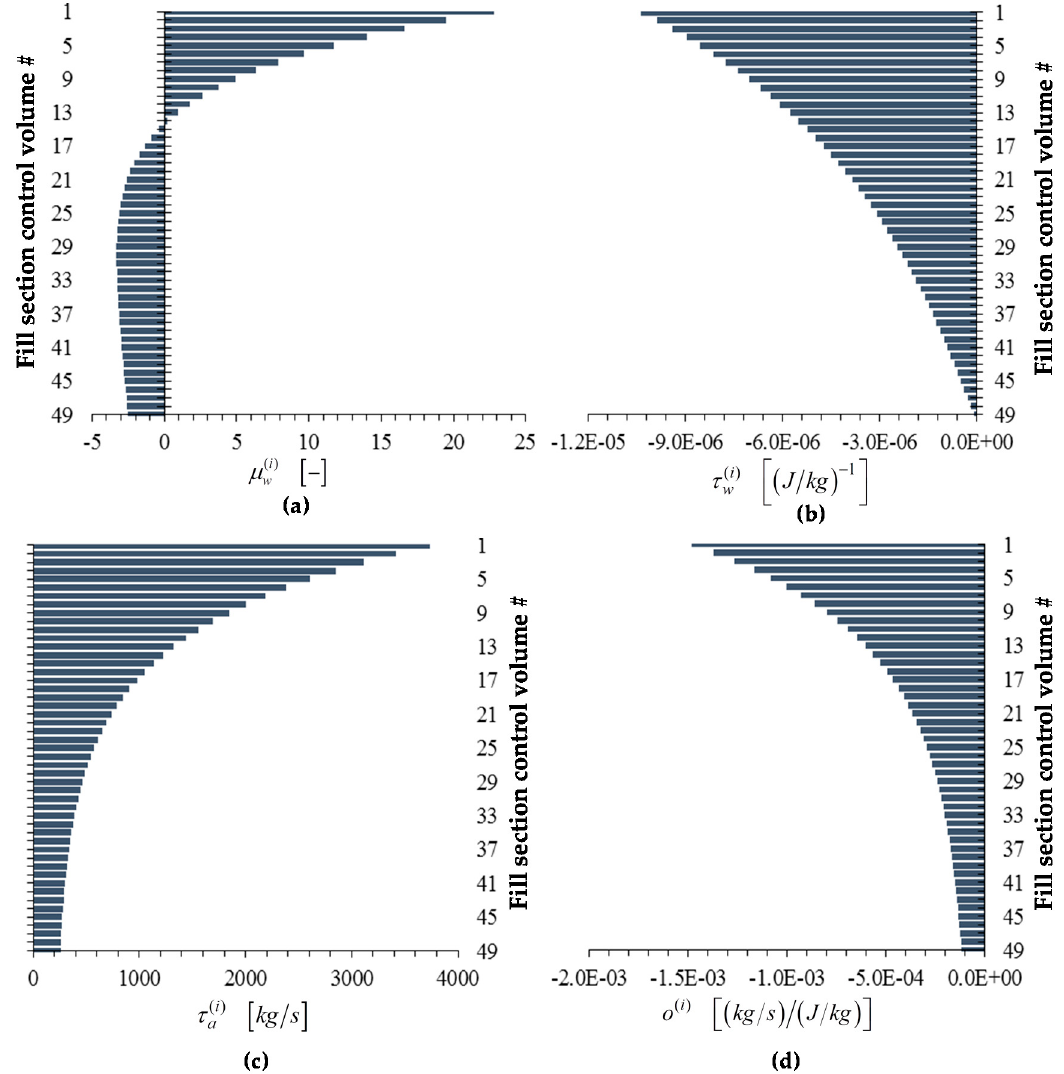
 R m , as functions of the height of the a (cid:16) (cid:17) (cid:16) (cid:17) (cid:16) (cid:17) ( 1 ) ( 49 ) ( 1 ) ( 49 ) ( 1 ) ( 49 ) µ τ τ ; ( b ) τ w (cid:44) ; ( c ) τ a (cid:44) ; w ,..., µ w w ,..., τ w a ,..., τ a